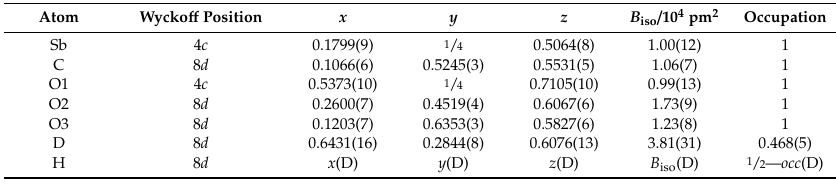
Table 1. Refined crystal structure of SbC 2 O 4 OD at T = 298(1) K and residual values of the Rietveld refinement based on neutron powder di ff raction; space group Pnma , a = 582.07(3) pm, b = 1128.73(5)